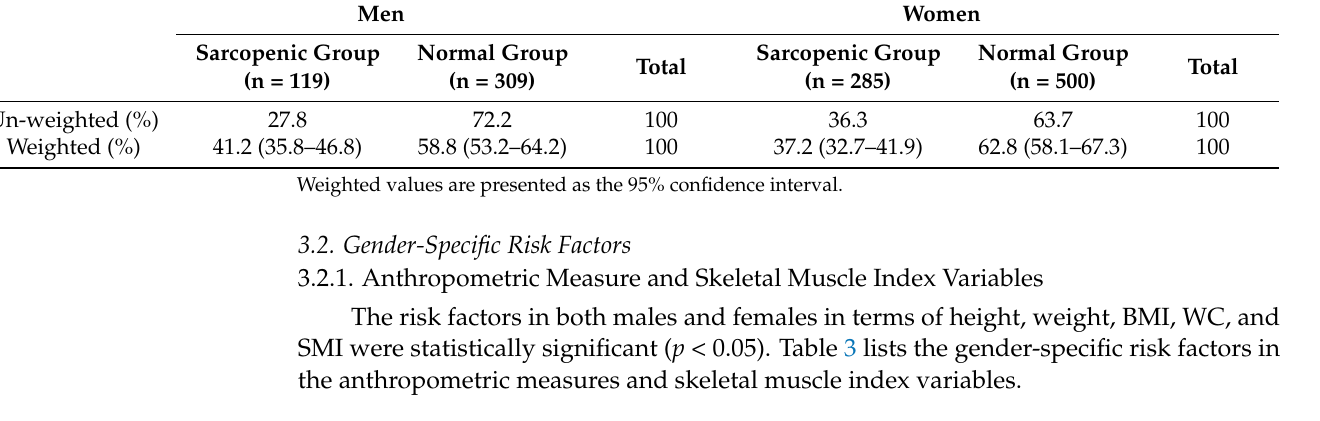
Table 3. Gender-specific risk factors in the anthropometric measures and skeletal muscle index